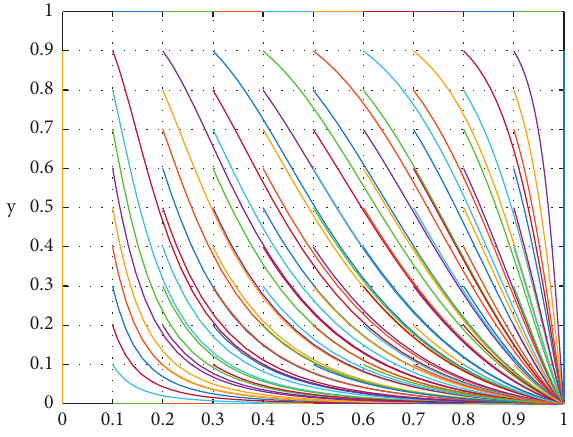
Figure 11: Evolution path when μ > α > ηβ and ε < ηβ − α <